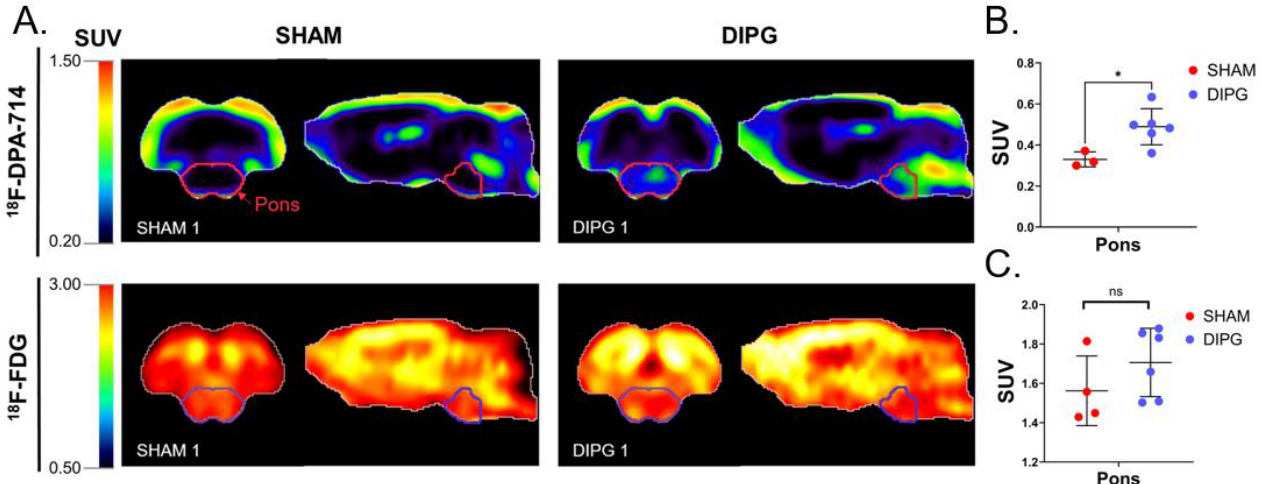
Figure 2. 18 F-FDG and 18 F-DPA-714 uptakes in the brain of DIPG-bearing and sham rats. ( A ) SUV- normalized brain PET images of 18 F-DPA-714 and 18 F-FDG uptakes in one sham (SHAM 1) and one tumor-bearing rat (DIPG 1). ( B ) Mean 18 F-DPA-714 SUV in the pons. ( C ) Mean 18 F-FDG SUV in the pons ( n = 4 in the sham group and n = 6 in the DIPG group). Statistical significance was determined using t -test with * p < 0.05. Data are represented as mean ± SD.